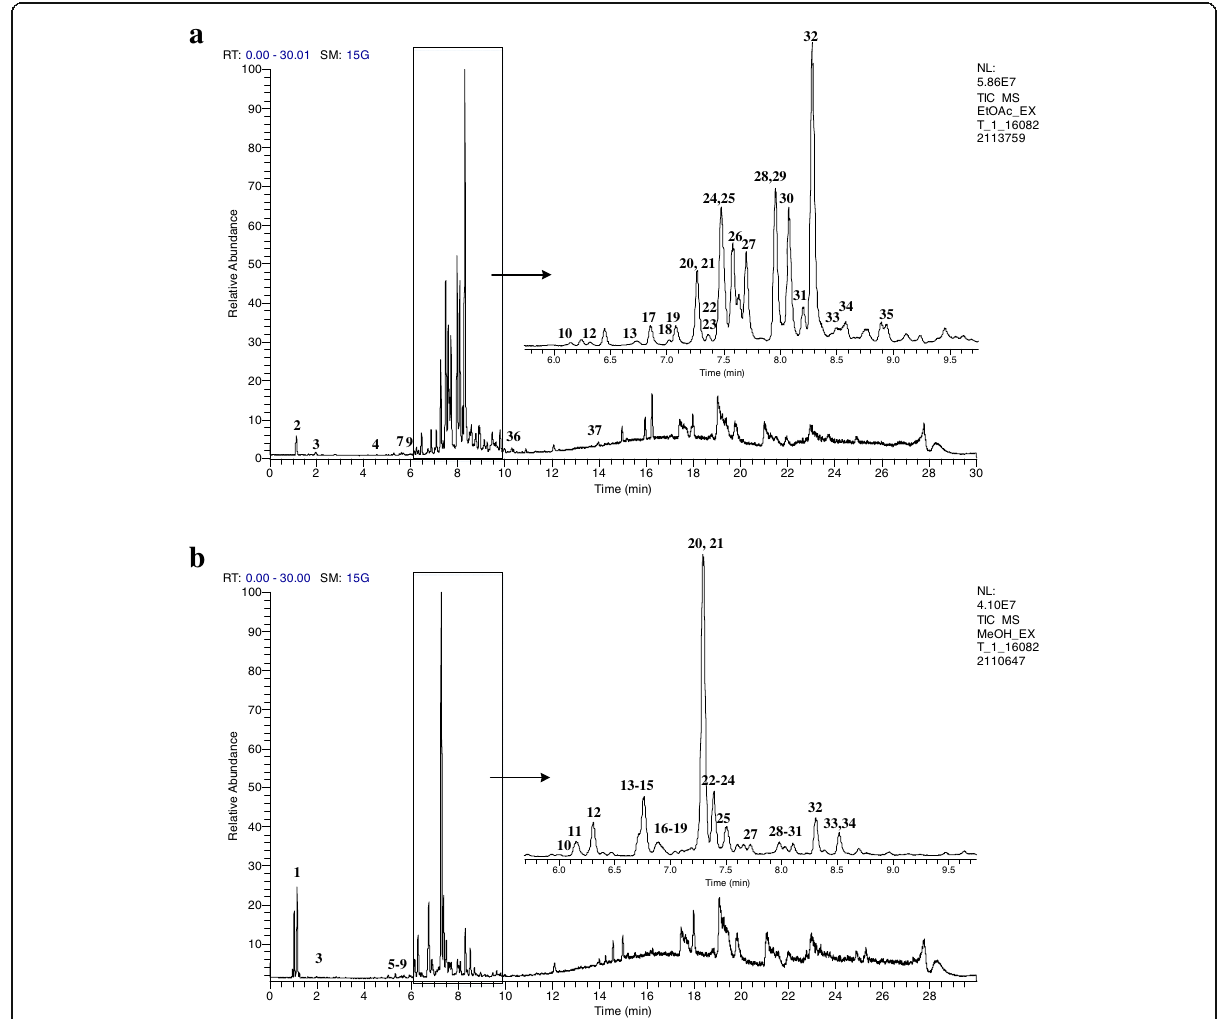
Fig. 7 The total ion chromatogram of EF ( a ) and MF ( b